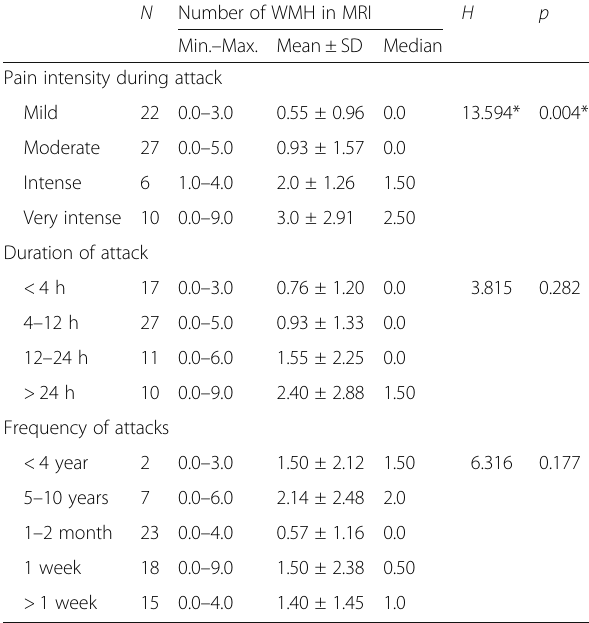
Table 4 Number of white matter hyperintensities and MIGSEV